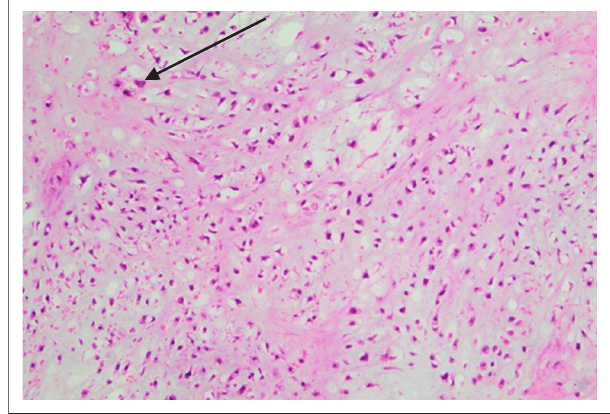
FIGURE 8: Haematoxylin and eosin staining, X 100 magnification. Neoplastic chondrocytes (black arrow) that are pleomorphic, occasionally vacuolated, bipolar and stellate. Some of the cells are binucleated.